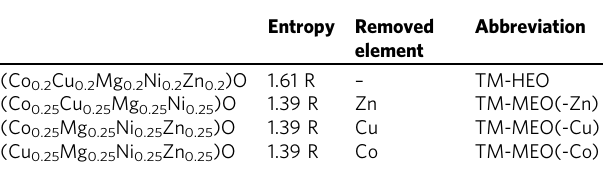
Table 1 Synthesized single-phase compounds used for electrochemical testing Entropy Removed element